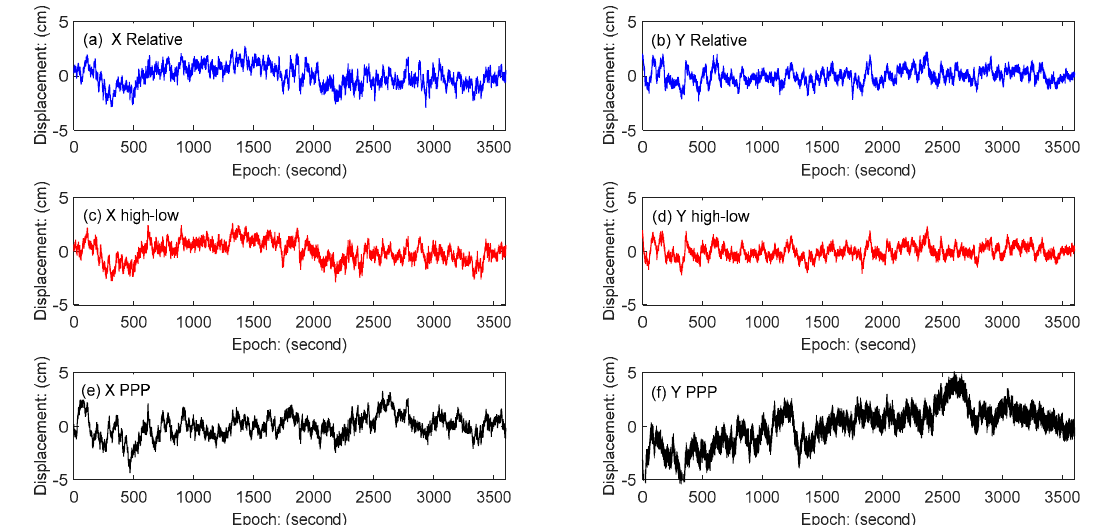
Figure 13. Quasi-static displacement time series: ( a ) X direction relative positioning method, ( b ) Y direction relative positioning method; ( c ) X direction combining high- and low-rate GPS method, ( d ) Y direction combining high- and low-rate GPS method; ( e ) X direction PPP method, ( f ) Y direction PPP method.